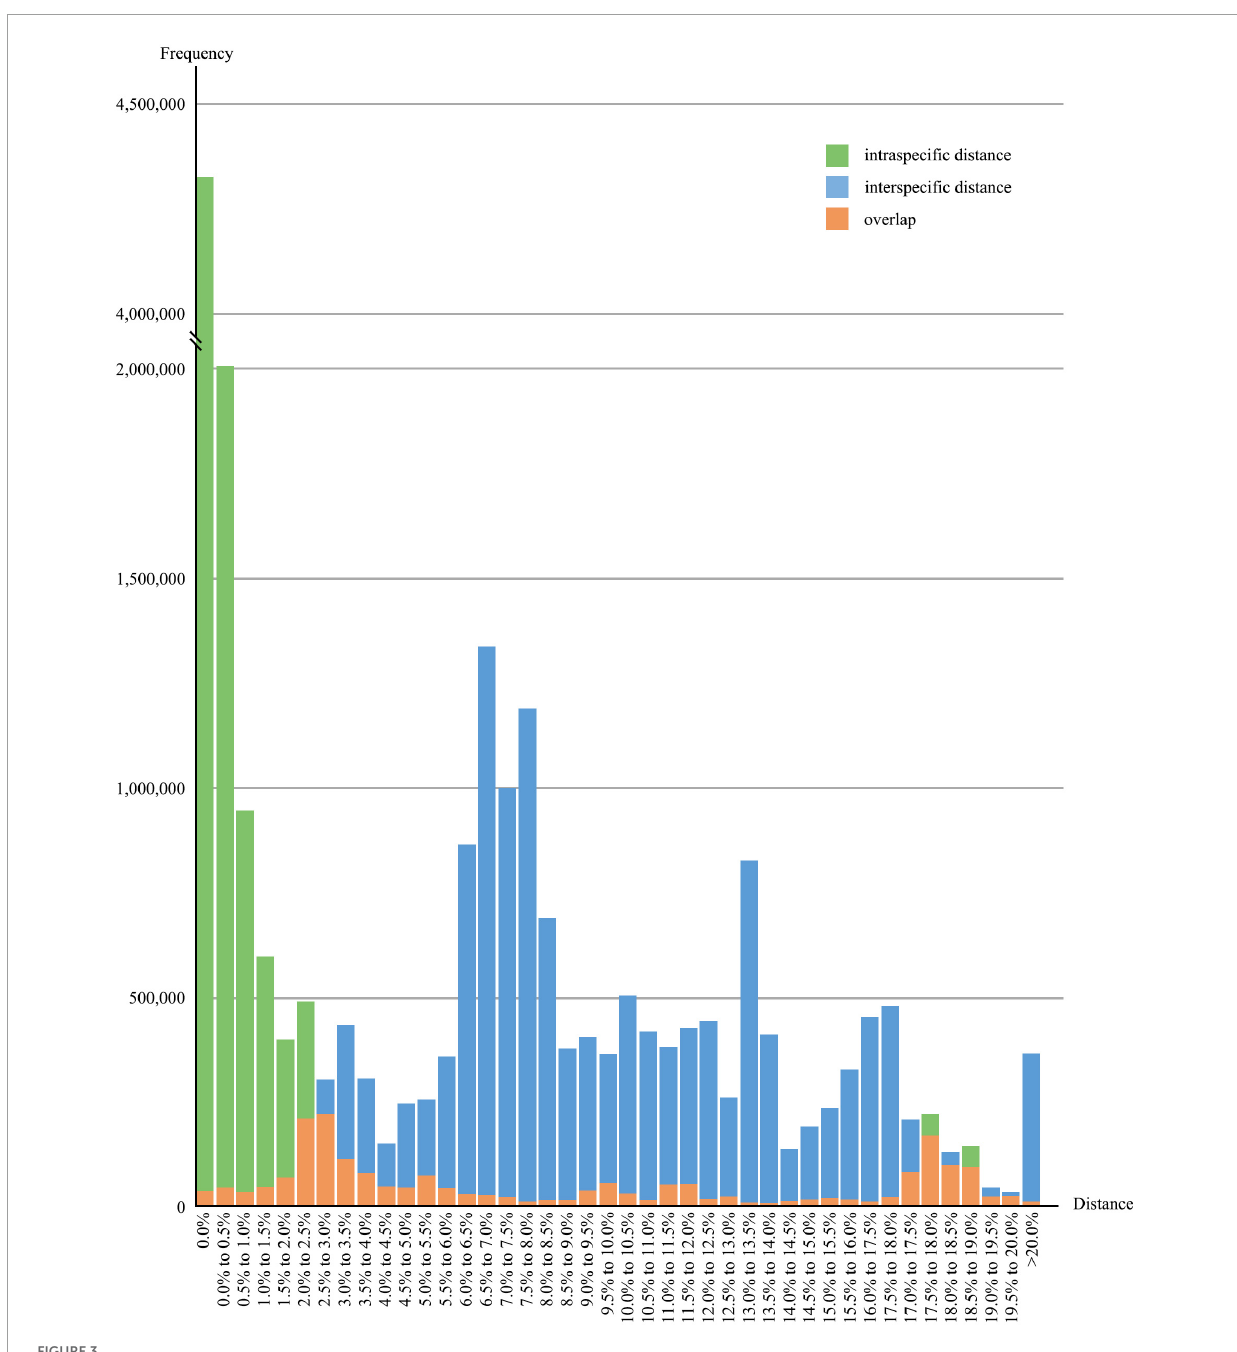
FIGURE3 Overall distribution of intra- and interspecific genetic distances. Green and blue bars represent the frequencies of intra- and interspecific K2P genetic distances, respectively; orange bars indicate the overlaps of intra- and interspecific distances.